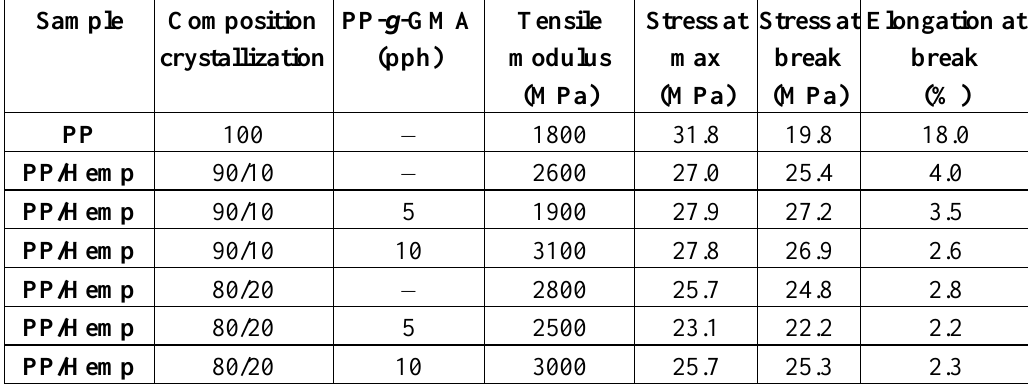
Table 1. Tensile properties of PP, PP/Hemp and PP/Hemp/PP- g -GMA composites.